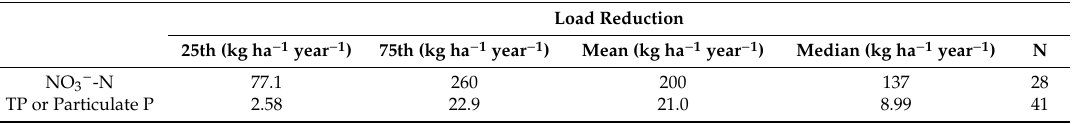
Table 1. Mass removal of nutrients in floodplains. Annual mass reductions in nitrate-N (NO 3 − -N) and total or particulate phosphorus (TP or particulate P) loads in floodplains from literature reviewed.